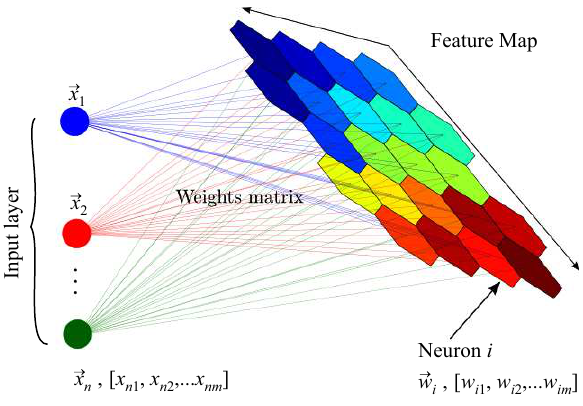
Fig. 7. Self-organizing map structure. Figure 7. Self-organizing map structure